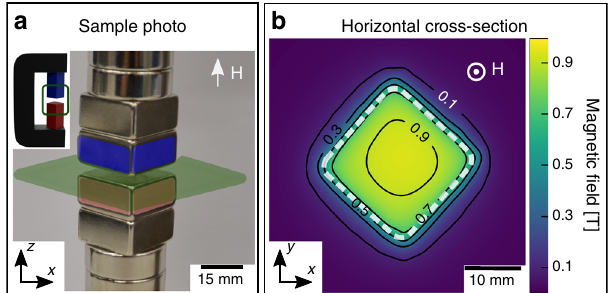
Fig. 2 Homogeneous, well-de fi ned, square-shaped, and uniaxial magnetic fi eld characterization. a The inset shows the sketch of the permanent magnets and the iron yoke along the beam direction. The photograph displays the air gap (4 mm) between the square-shaped pole shoes (blue and red), which produce a square-shaped uniaxial magnetic fi eld and the 45° orientation permanent magnets around the vertical axis. b Hall probe map of the measured magnetic fi eld between the squared-shaped pole shoes, as depicted by the green horizontal cross-section plane in a . The white dashed line indicates the edges of the permanent